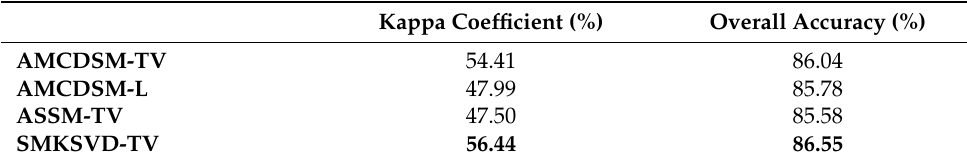
Table 5. Pavia university hyperspectral data: Kappa coefficient and Overall Accuracy.